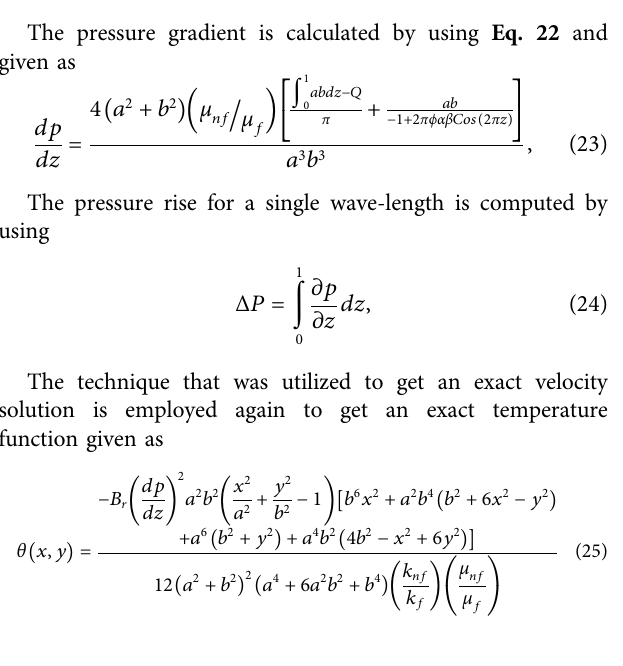
plot against axial coordinate for dz